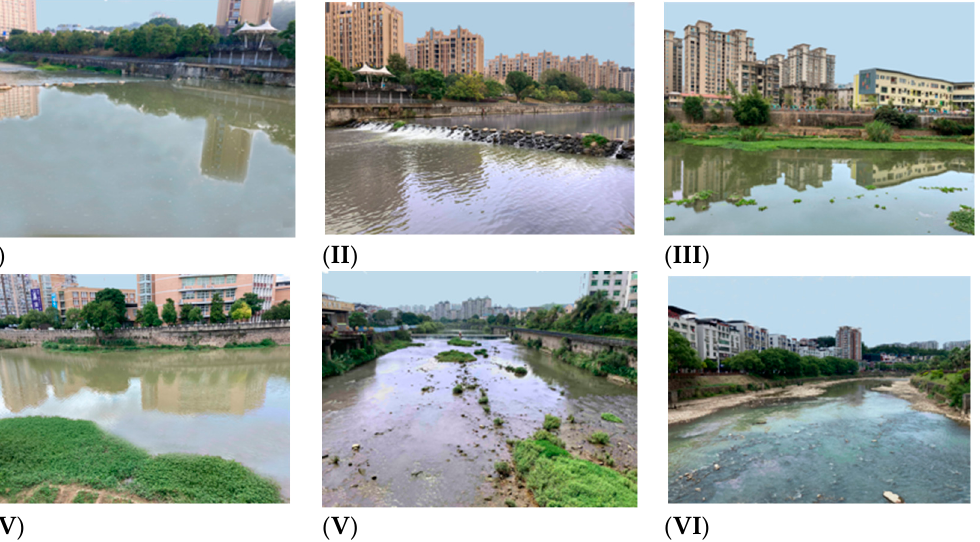
Figure 2. Six images from locations ( I – VI) , along the Baxi stream. ( I , II ) A cross-river view taken from the rubble dam upstream to downstream and the rubble dam downstream to upstream, respectively. ( III ) A cross-river view taken from upstream of the dam affected by backwater. Most of the floating vegetation is distributed toward the right bank. ( IV ) A cross-river view taken from upstream of the dam affected by backwater, showing that most of the emergent plants are distributed on the left bank. ( V ) A flow-axis view taken from the dam downstream when the rubber dam is raised. ( VI ) A flow-axis view taken from the rubber dam upstream when the dam is lowered.